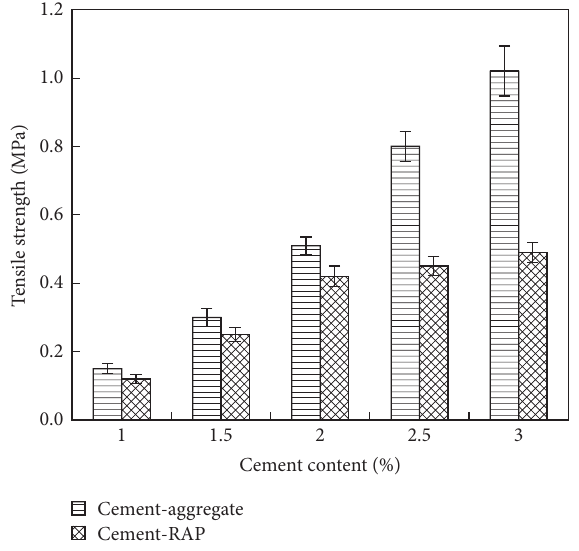
Figure 13: Tensile strength for cement-RAP mixture and cement- aggregate